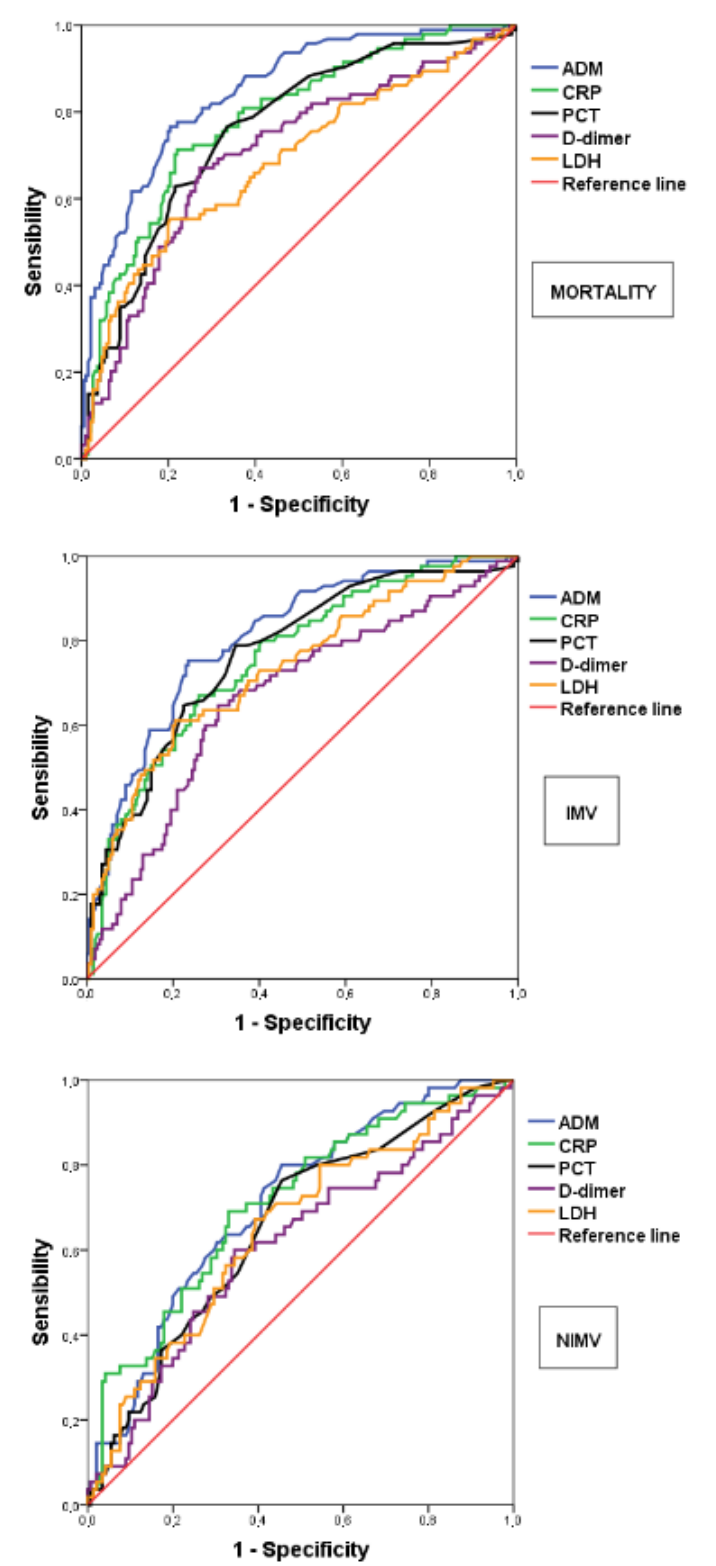
Figure 1. Association of candidate biomarkers with mortality and mechanical ventilation. AUROC, Area Under the Receiver Operating Characteristic curve. MR-proADM, mid-regional pro- drenomedullin; CRP, C-reactive protein; PCT, procalcitonin; LDH, lactate dehydrogenase; IMV, Invasive Mechanical Ventilation; NIMV, Non-Invasive Mechanical